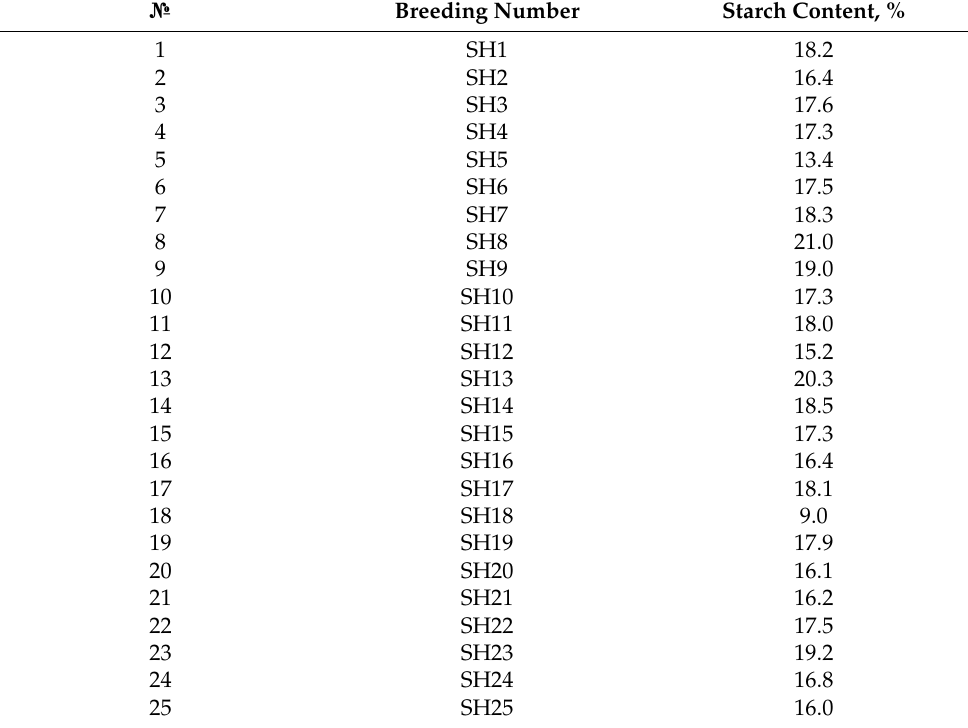
Table 7. Starch content (%). № Breeding Number Starch Content,